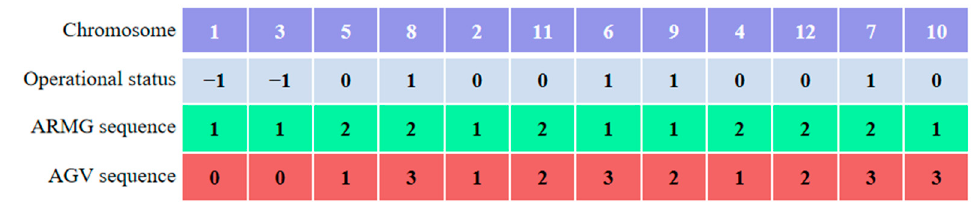
Figure 7. Chromosome decoding construction.